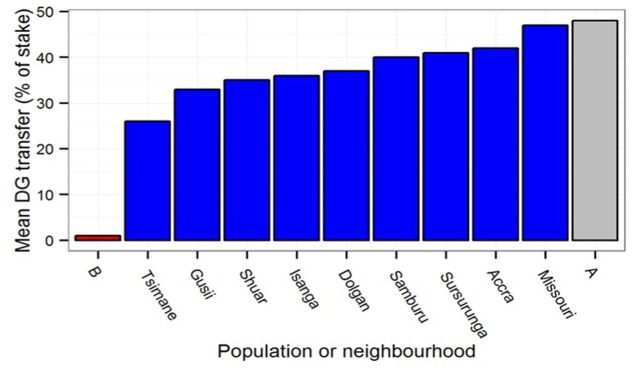
Mean dictator game offer in the deprived (B) and less deprived (A) neighborhoods in Nettle et al. (2011) compared to mean population offers from cross-cultural data in Henrich et al. (2010).